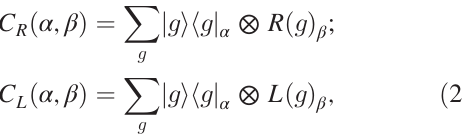
and C described in the main text. L R ~ jþi